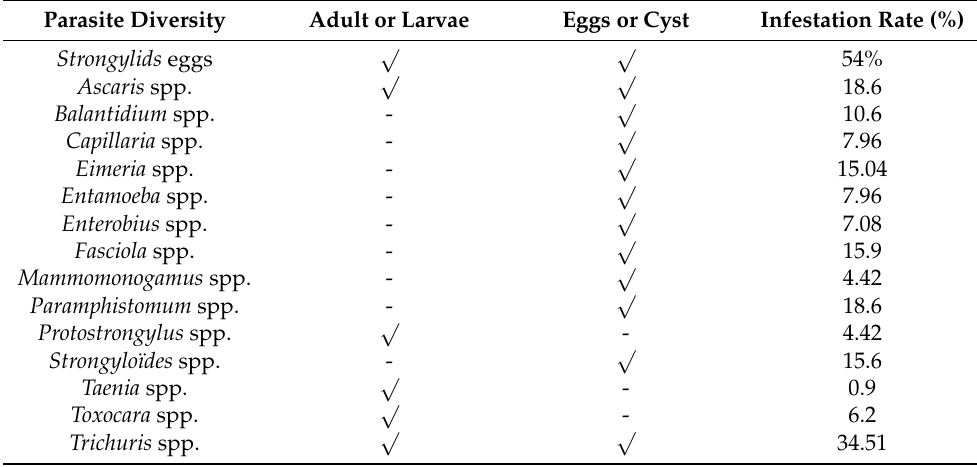
Table 2. Parasitic form and infestation rates of identified parasite genera. Parasite